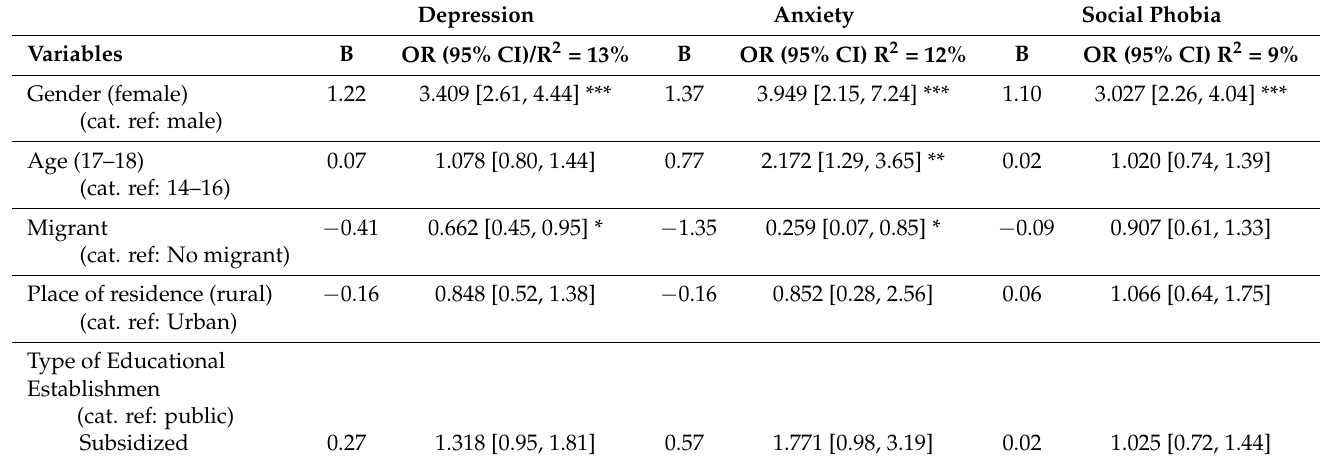
Table 5. Multivariate logistic regression analysis of risk factors associated with symptoms of depres- sion, anxiety, and social phobia.